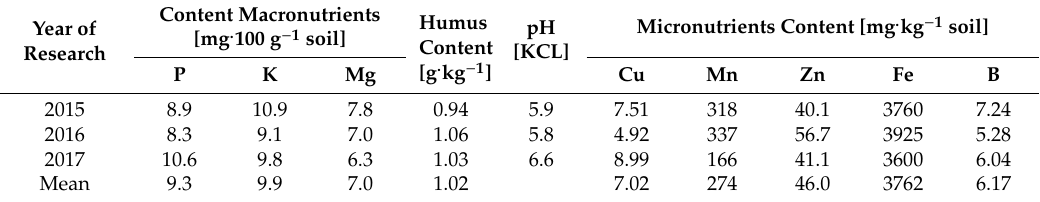
Table 3. Physico-chemical characteristics of the soil before establishing the experiment in